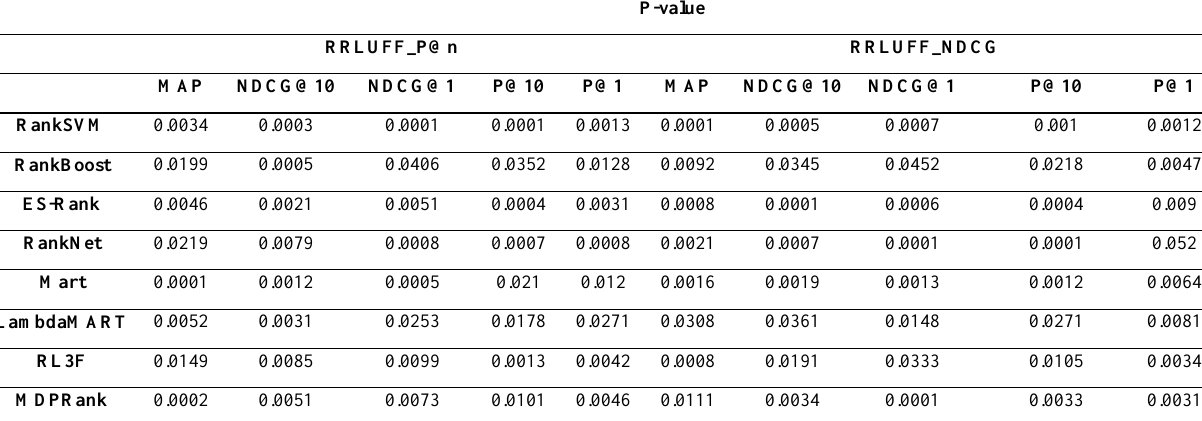
Table 2. The statistical significance of the p-value (paired t-test) between RRLUFF and other compared methods on DOTIR